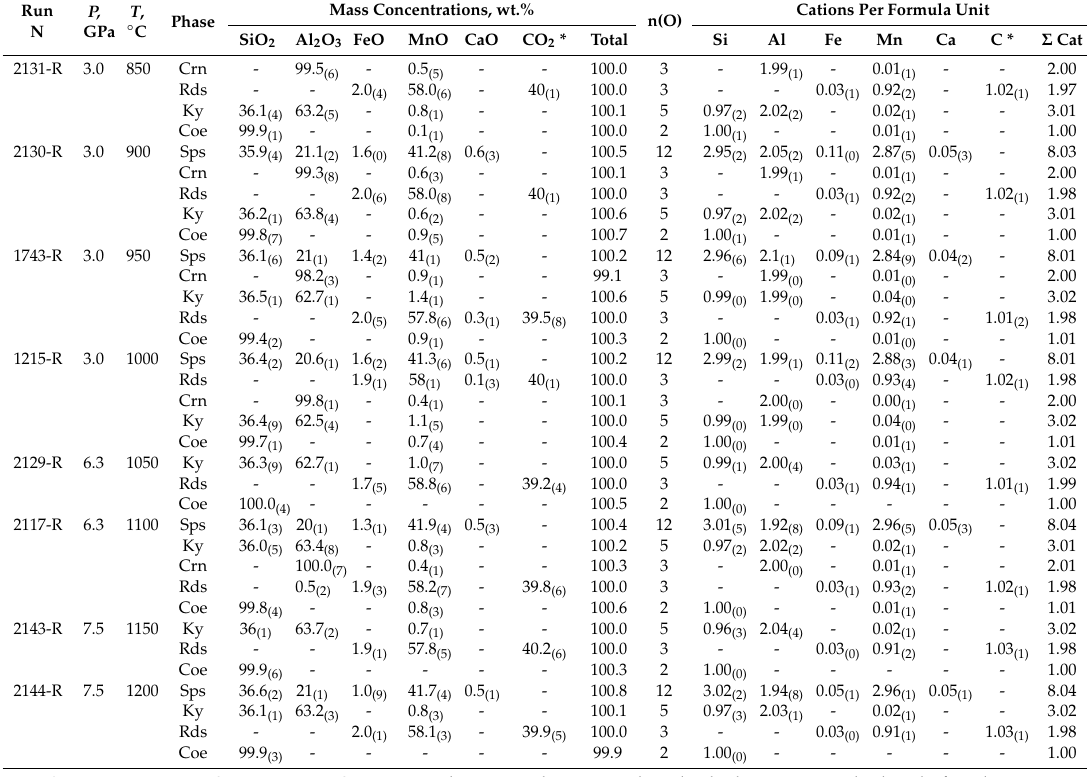
Sps—spessartine, Coe—coesite, Crn—corundum, Ky—kyanite, Rds—rhodochrosite; *—calculated after the sum deficit; the values in parentheses are one sigma errors of the means based on replicate electron microprobe analyses